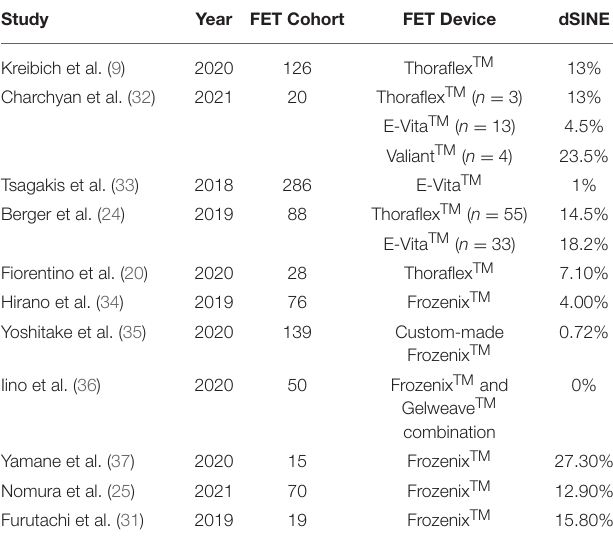
TABLE 5 | Summary of results in Is Aortic Remodeling Correlated With dSINE? Study Year FET Cohort FET